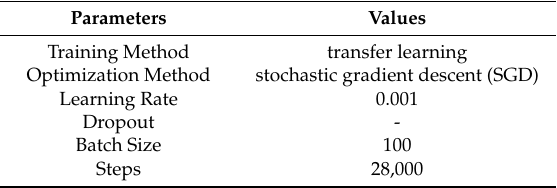
Table 1. Training parameters of the shadow classifier.